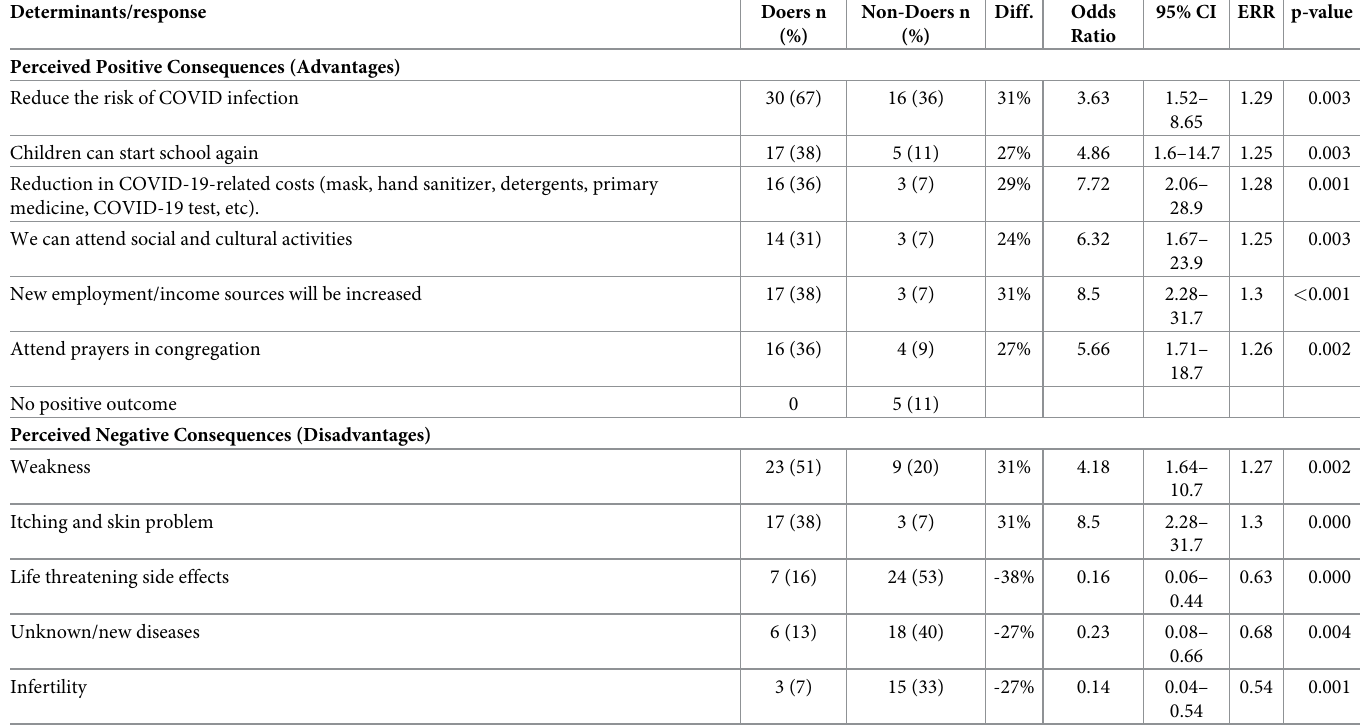
Table 5. Perceived positive and negative